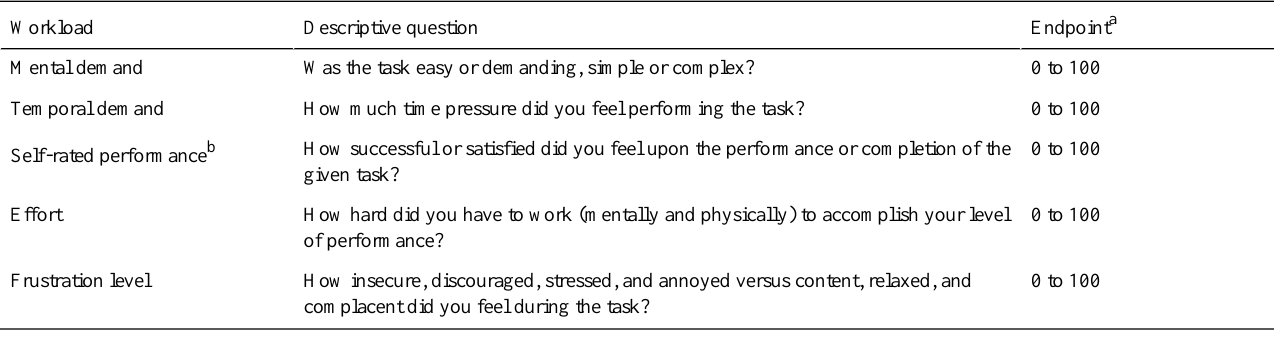
Table 2. Description of the modified raw National Aeronautics and Space Administration Task Load Index questions and rating